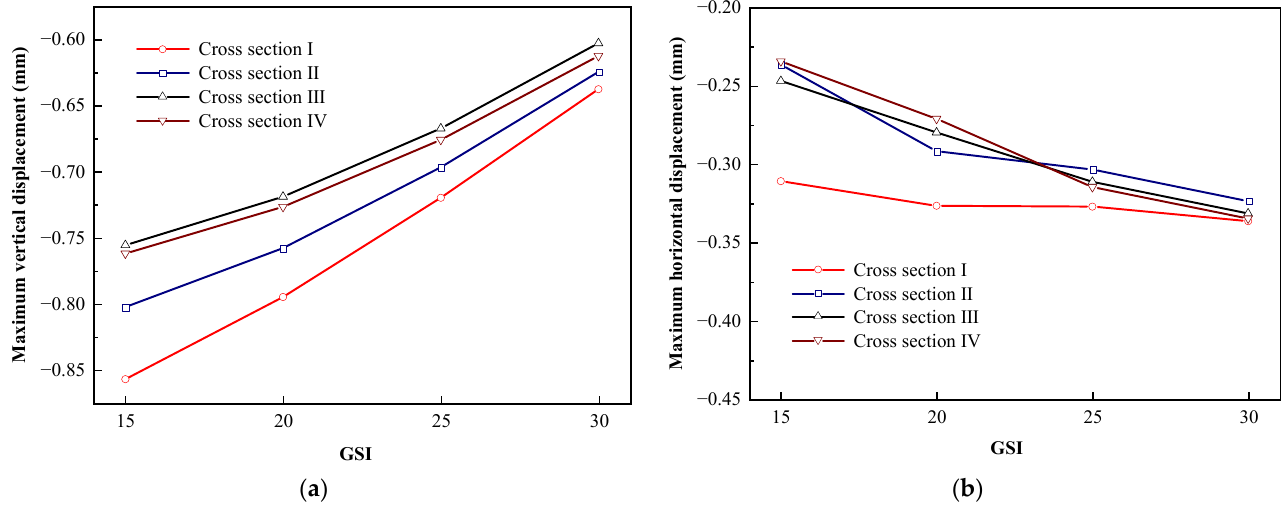
Figure 14. Relationship between GSI and: ( a ) Maximum vertical displacement of vault, and ( b ) maximum horizontal displacement of the adjacent side wall.